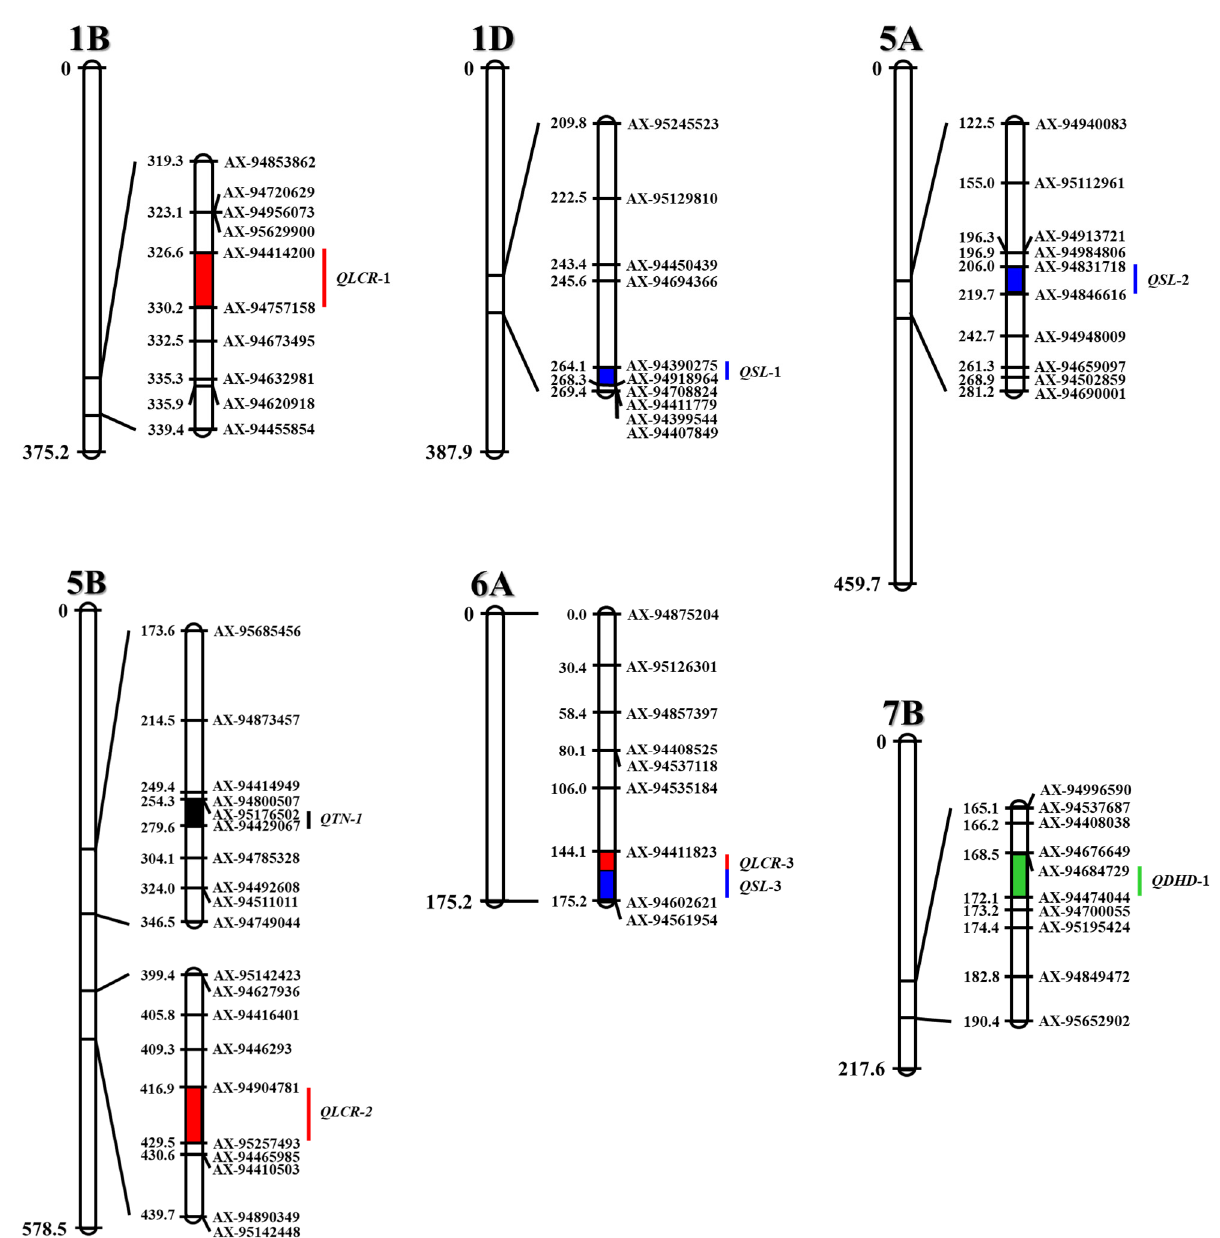
Figure 4. SNP-based QTL mapping for yield potential traits in 94 F 10 recombinant inbred lines produced from the cross between Taejoong and Keumkang. SL, spike length; DHD, days to heading date; TN, number of tillers; LCR, length of center